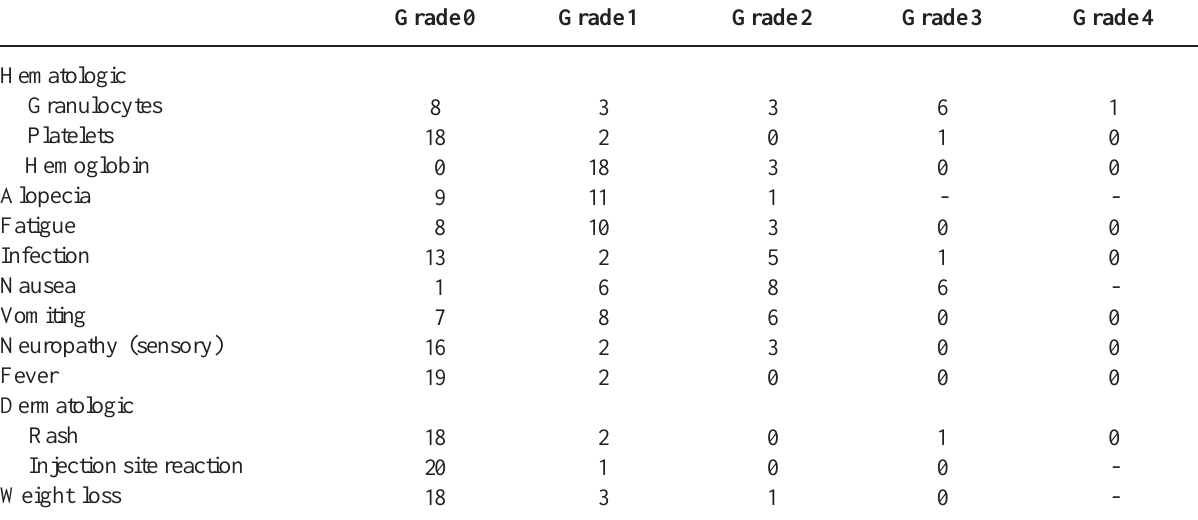
Table 2 – Toxicity of gemcitabine plus cisplatin: worst toxicity by patient (n = 21).